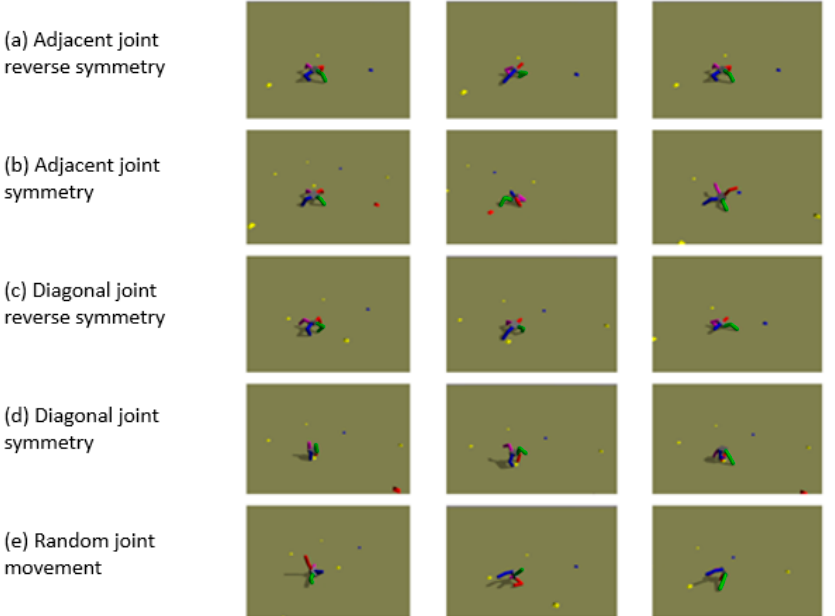
Figure 11. Robot movements in the simulator are based on the symmetry used. ( a ) shows the adjacent reverse symmetry. ( b ) shows the adjacent symmetry. ( c ) shows the diagonal reverse symmetry. ( d ) shows diagonal symmetry, and ( e ) shows random joint movement.